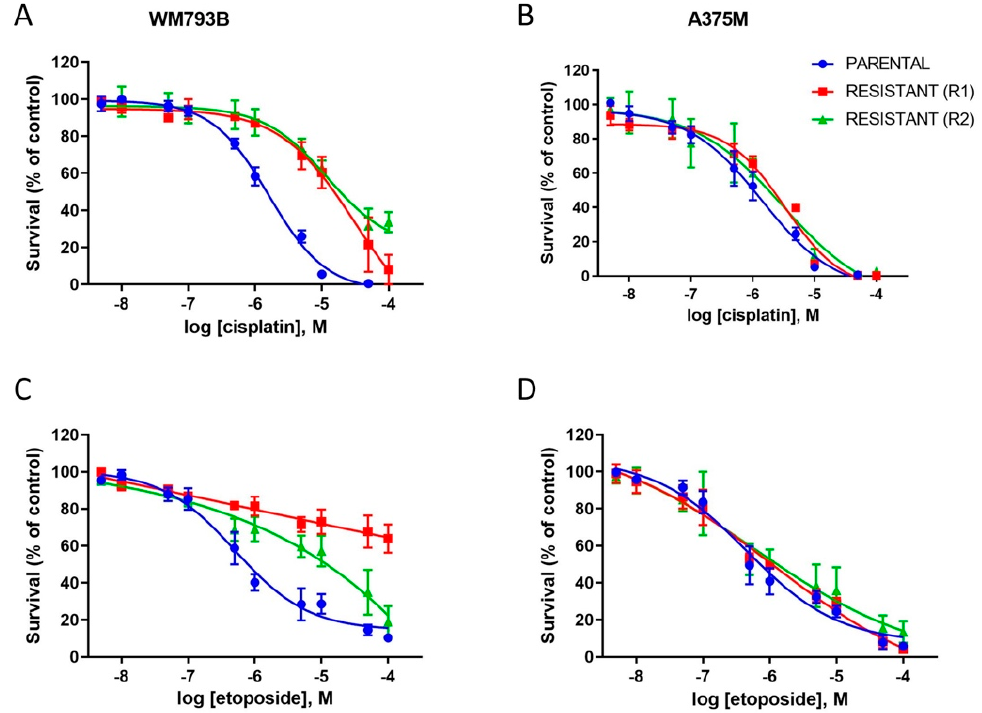
Figure 6. Differential sensitivity of parental and resistant WM793B and A375M cell lines to cisplatin and etoposide. WM793B and A375M parental and resistant cells were exposed to serial dilutions of cisplatin and etoposide for 72 h, and the cell viability was assessed by MTT assay. Vemurafenib-resistant WM793B cells increased tolerance to both cisplatin ( A ) and etoposide ( C ). On the other hand, vemurafenib-resistant A375M cells showed similar resistance to cisplatin ( B ) and etoposide ( D ) as parental cells. Each dose–response curve represents the mean ± SD from three to five independent experiments.